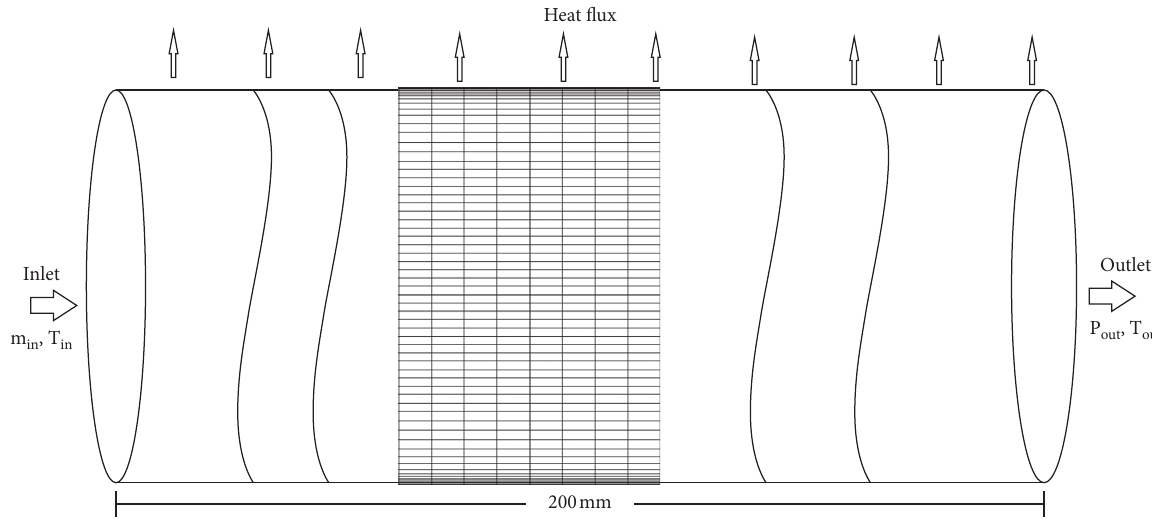
Figure 3: Physical model.